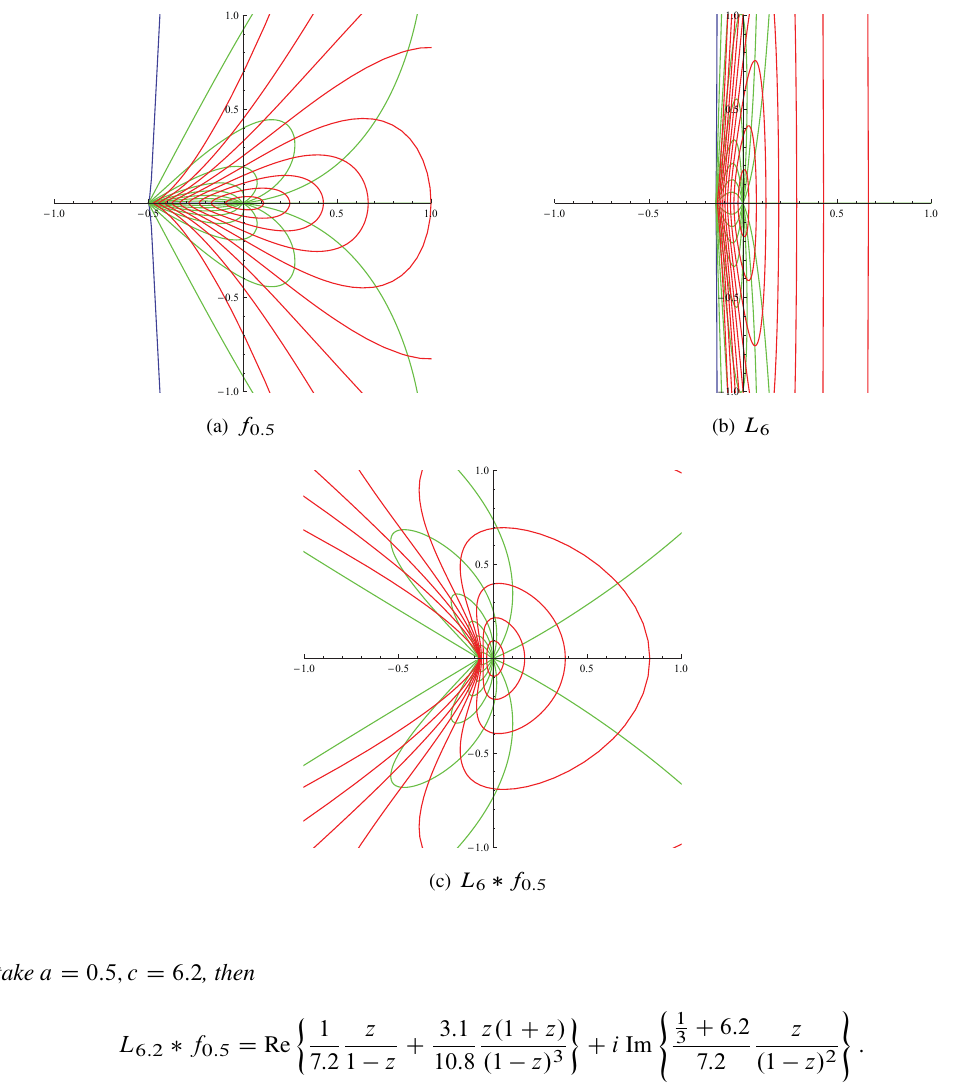
The image of U under L 6:2 (cid:3) f 0:5 is shown in Figure 4 (a). Figure 4 (b) is a partial enlarged view of Figure 4 (a) showing that the images of two outer most concentric circles in U are intersecting and so L 6:2 (cid:3) f 0:5 is not